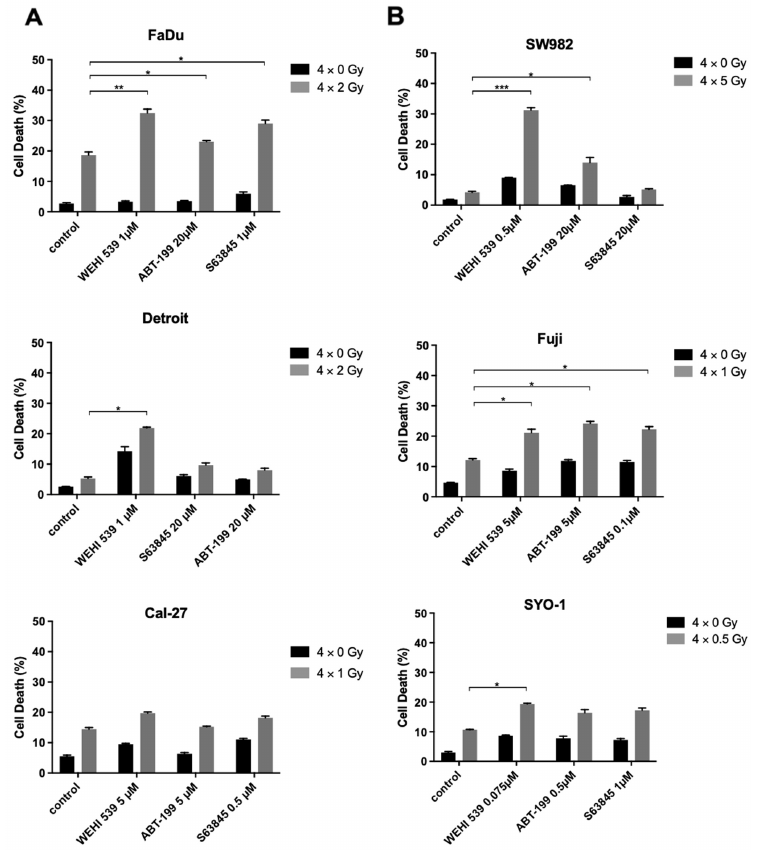
Figure 4. Radiosensitization results of HNSCC and synovial sarcoma cell lines Combination of irradiation and molecular inhibition in ( A ) HNSCC and ( B ) synovial sarcoma cell lines measured by FACS analysis. Experiments were performed in triplicate and cell death was measured as mean ± SD. The depicted FACS analyses are representative of at least three independent experiments. * p ≤ 0.05, ** p ≤ 0.01, *** p ≤ 0.001.